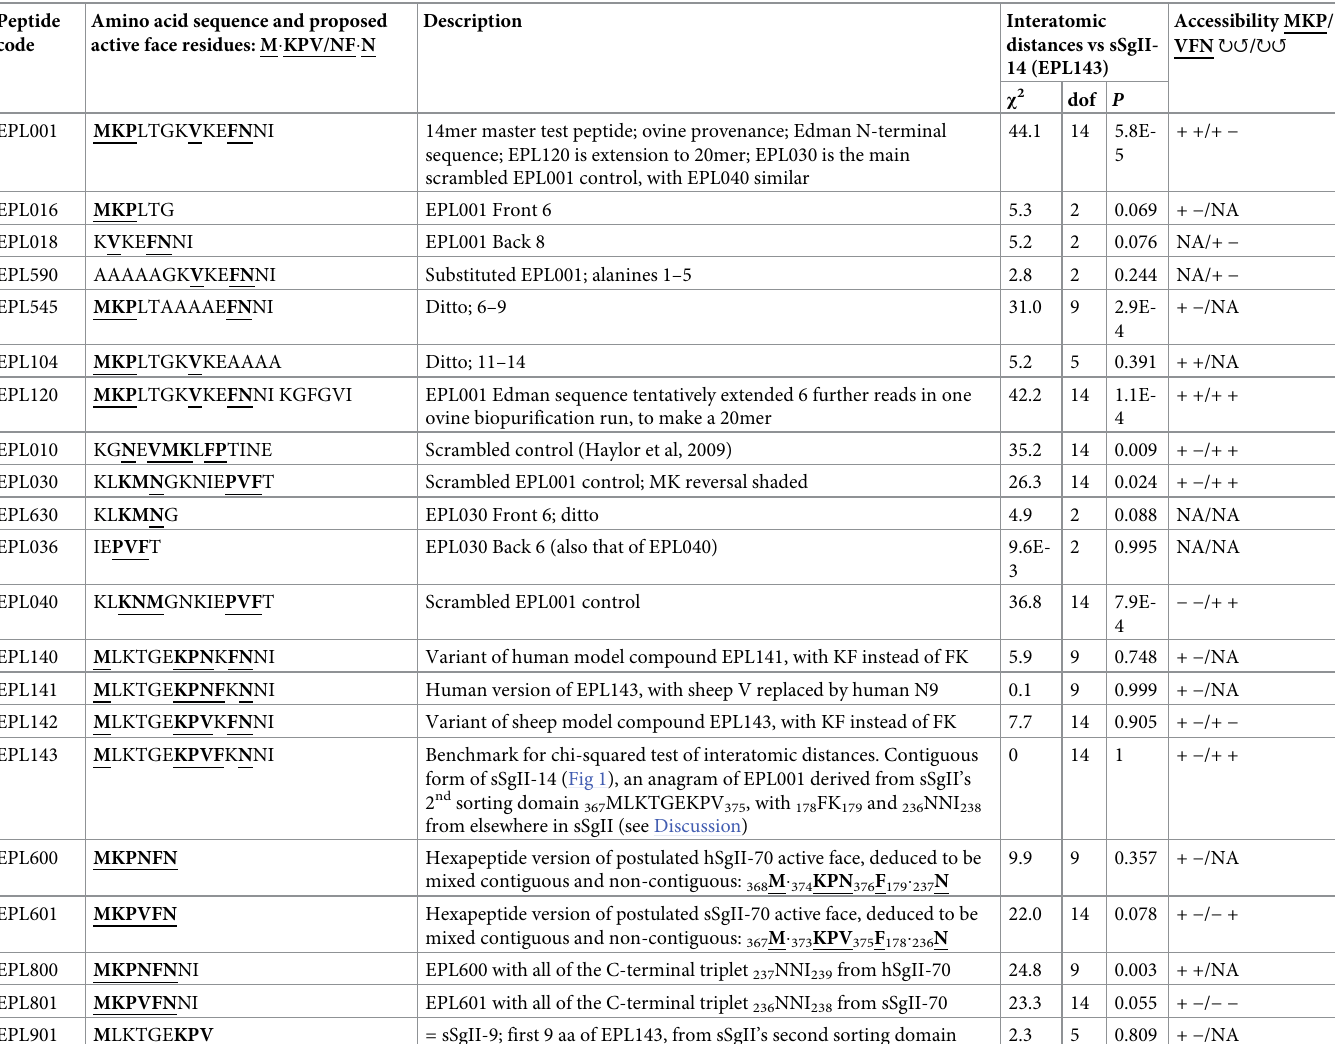
Table 1. Synthetic peptides with SgII-related proposed active face residues indicated. For structure-activity purposes, interatomic distances have been measured between six atoms of the proposed active face residues using molecular models in silico. Twenty peptides provided the observed (O) distances for a chi-squared hypothesis test of SgII-relatedness, with the expected (E) interatomic distances from EPL143, a contiguous version of sSgII-14 (Fig 1). χ 2 = S (O–E) 2 /E; dof = degrees of freedom; P = probability; E-5 = x10 -5 etc. The righthand column shows the accessibility for receptor binding of active face aa side chains, each tri-residue module viewed clockwise and counter-clockwise. Control tri-residues: MK7 xx P / N x V xxx F (EPL010); K3M xxxxxx P / N5 xxxxxx VF (EPL030); & K3 x M xxxxx P / N4 xxxxxxx VF (EPL040). NA = not applicable. Peptide Amino acid sequence and proposed code active face residues: M � KPV/NF �